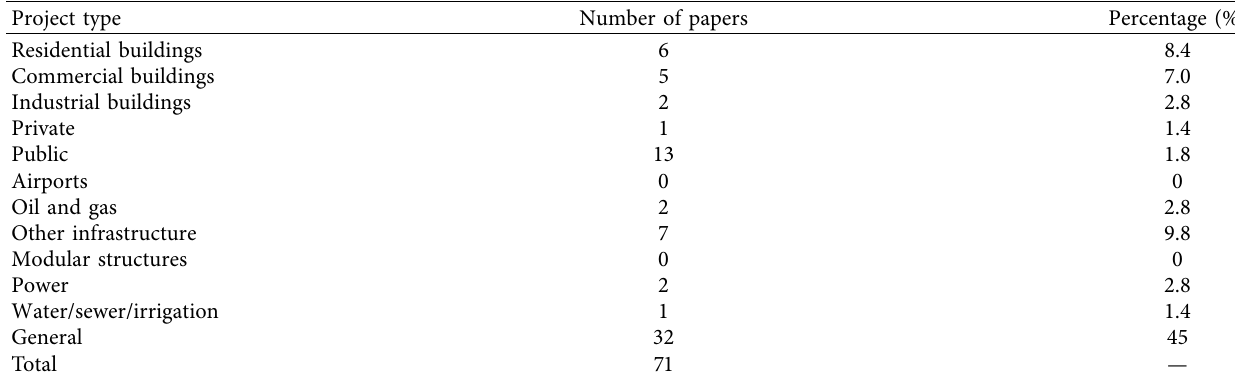
Table 14: Mapping project types for papers on construction